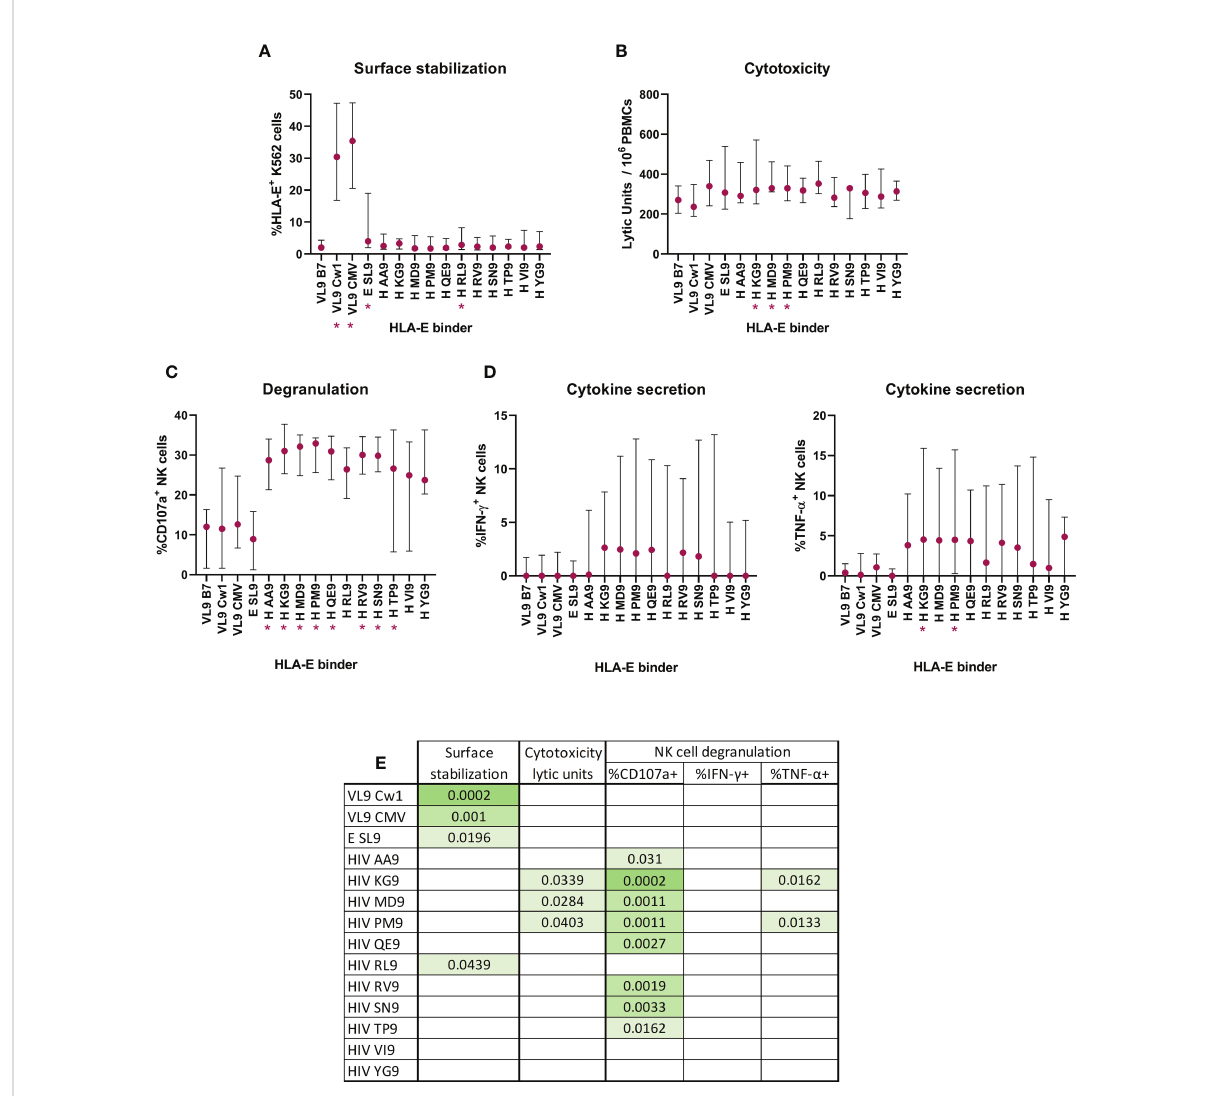
FIGURE 6 Effect of HIV-1 derived peptides on HLA-E*01:03 surface stabilization and consequent ability to alter NK functionality. HLA-E *01:03 transfected K562 cell line co-expressing the VL9 epitope was pulsed with canonical and non-canonical HLA-E binding peptides. (A) Peptide-pulsed cells induced HLA-E surface stabilization, measured by fl ow cytometry and recorded as %HLA-E+ K562 cells. Peptide-pulsed cells modi fi ed the NK cytotoxic capacity (B) , degranulation (C) and cytokine secretion ( D , IFN- g (left) and TNF- a (right)). Multiple comparisons with the control VL9 epitope were performed by Friedman ’ s test for paired data with post-hoc False discovery rate. Signi fi cant differences are marked in the graphs with * and (A-D) correspond to p-values<0.05. Table (E) represents signi fi cant p-values when FDR indicated